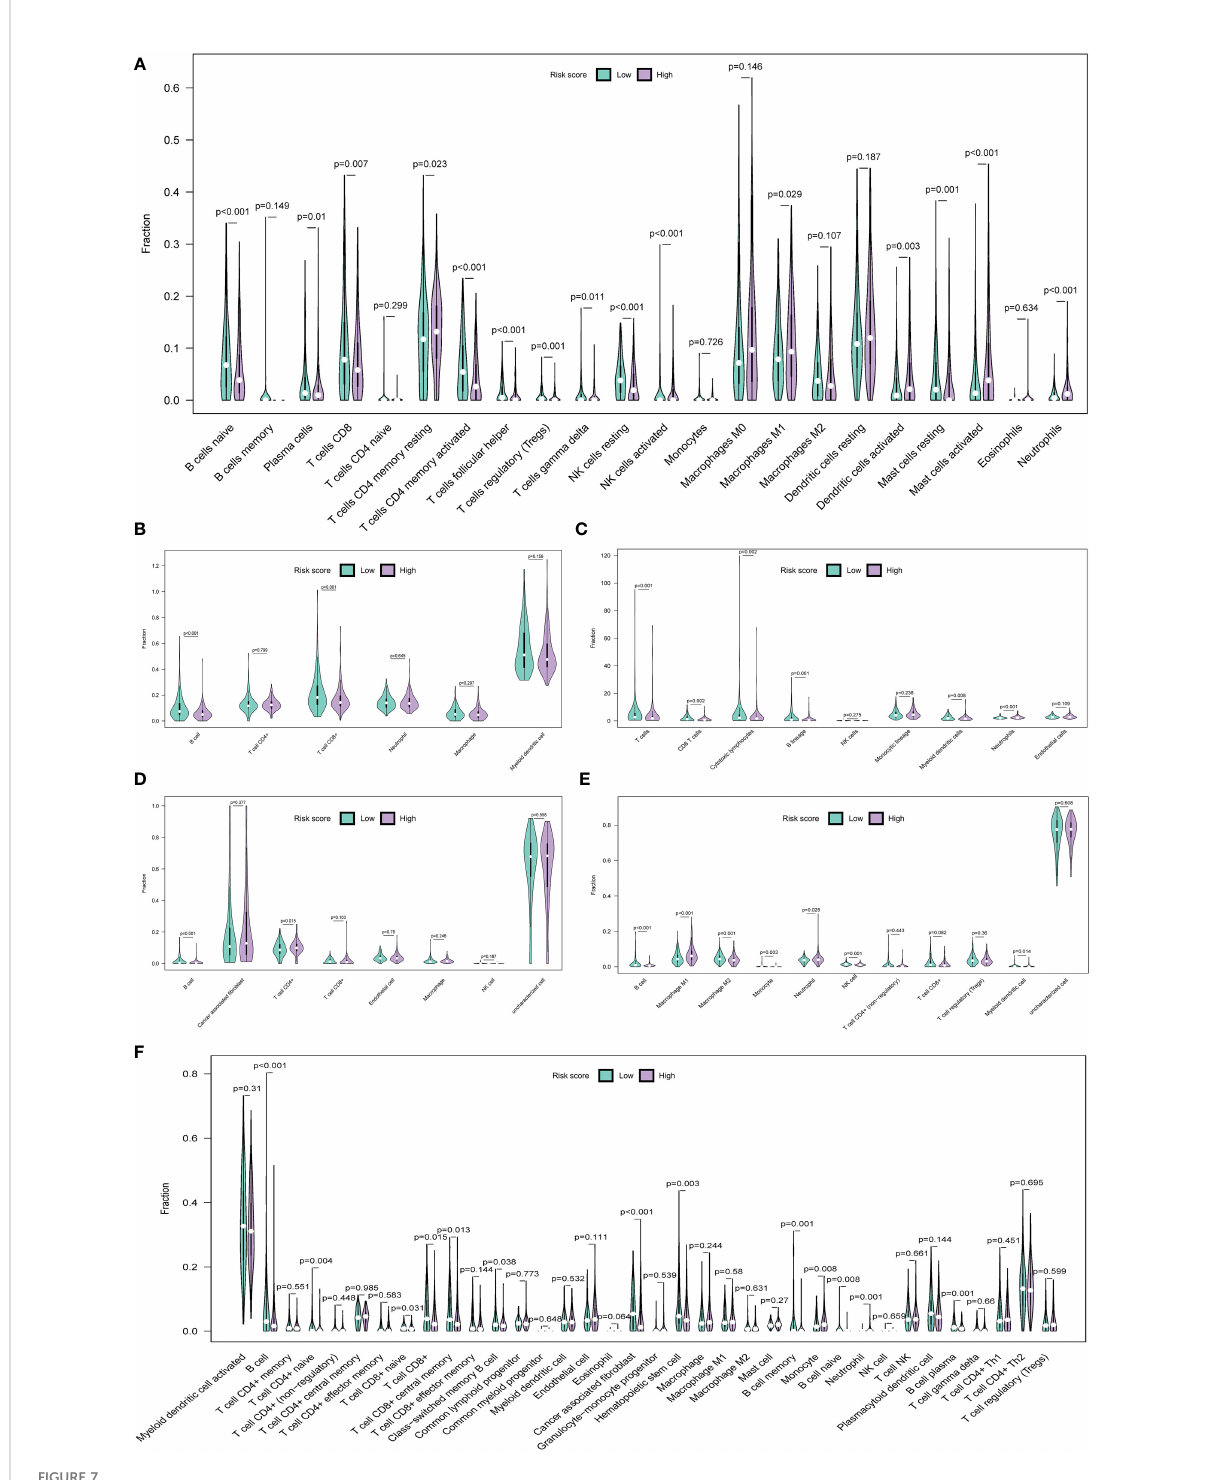
FIGURE 7 The immune landscape of the TME in HNSCC and the differences between the high- and low-risk groups. Multiple violin plots showed the abundance of in fi ltration immune cells in the high- and low-risk groups in the CIBERSORT algorithm (A) , TIMER algorithm (B) , MCP-count algorithm (C) , EPIC algorithm (D) , quanTIseq algorithm (E) , and xCell algorithm (F)